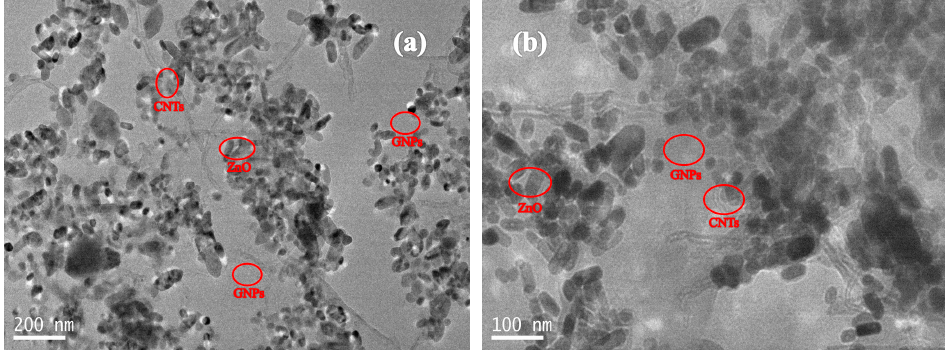
Figure 3. TEM image ( a ) and high magnification TEM image ( b ) of the GNPs-CNTs-ZnO hybrid.